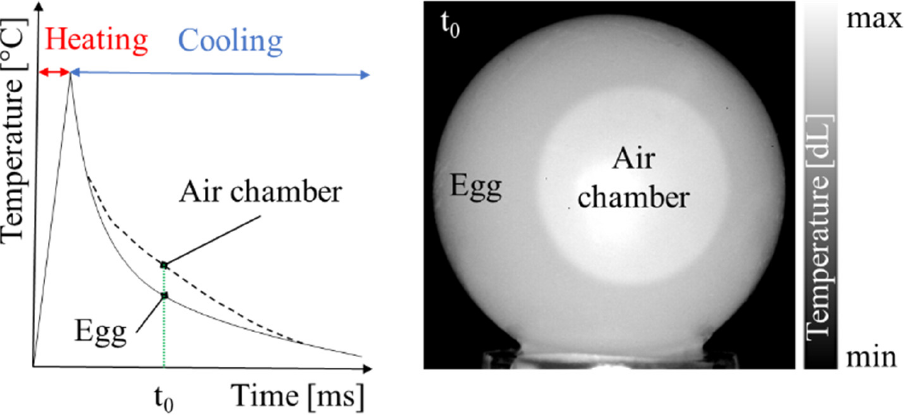
Figure 3. Conceptualization of PT in the presented method.